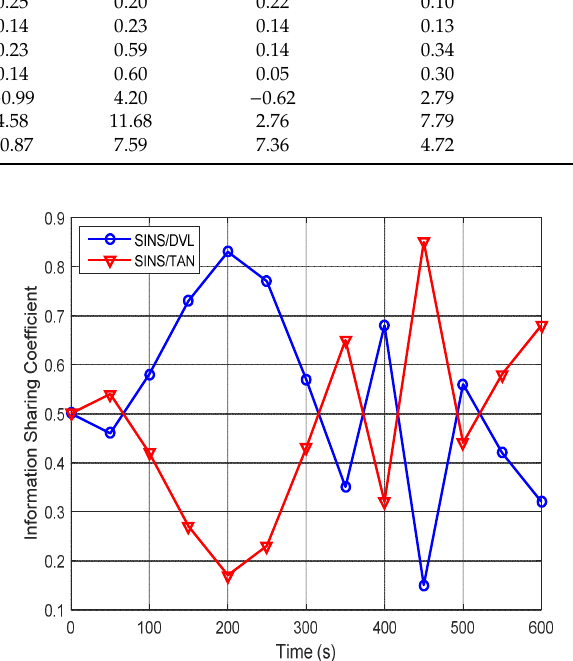
Figure 22. The values of the information sharing coefficient.